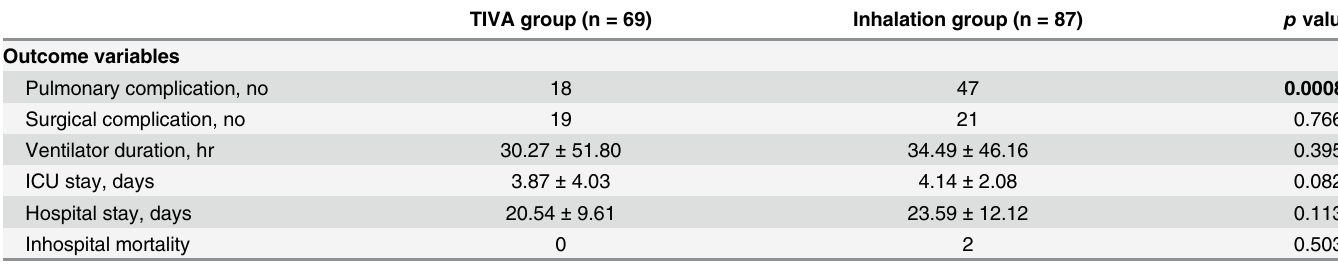
Table 3. Postoperative outcome between TIVA and inhalation